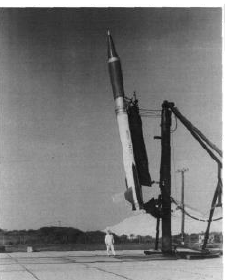
Figure 11. An example of parachute flight test via